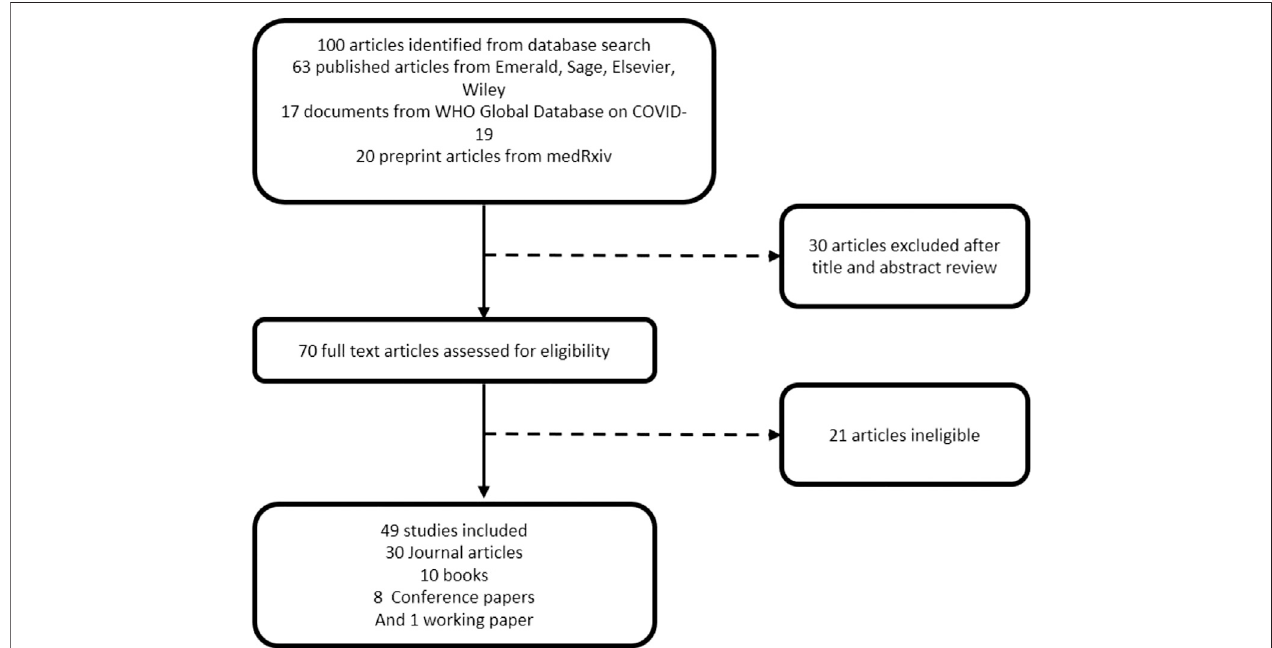
FIGURE 1 | Article Selection criteria